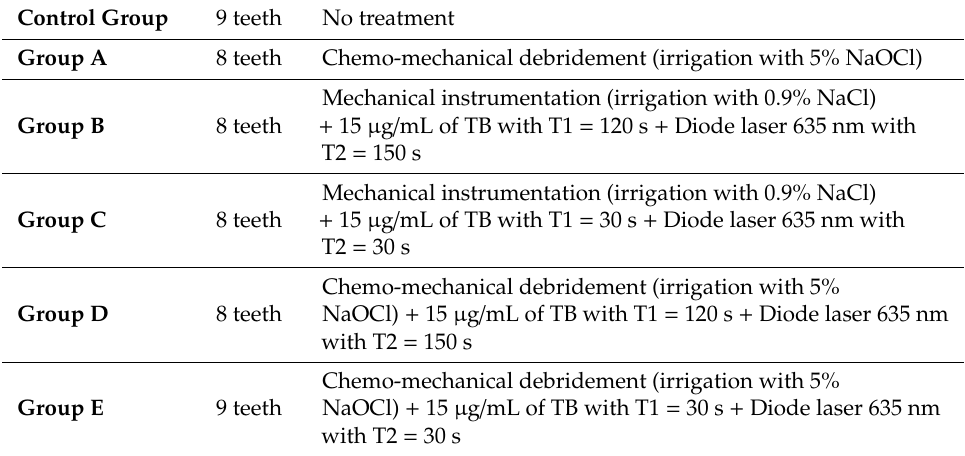
Table 1. Description of the study